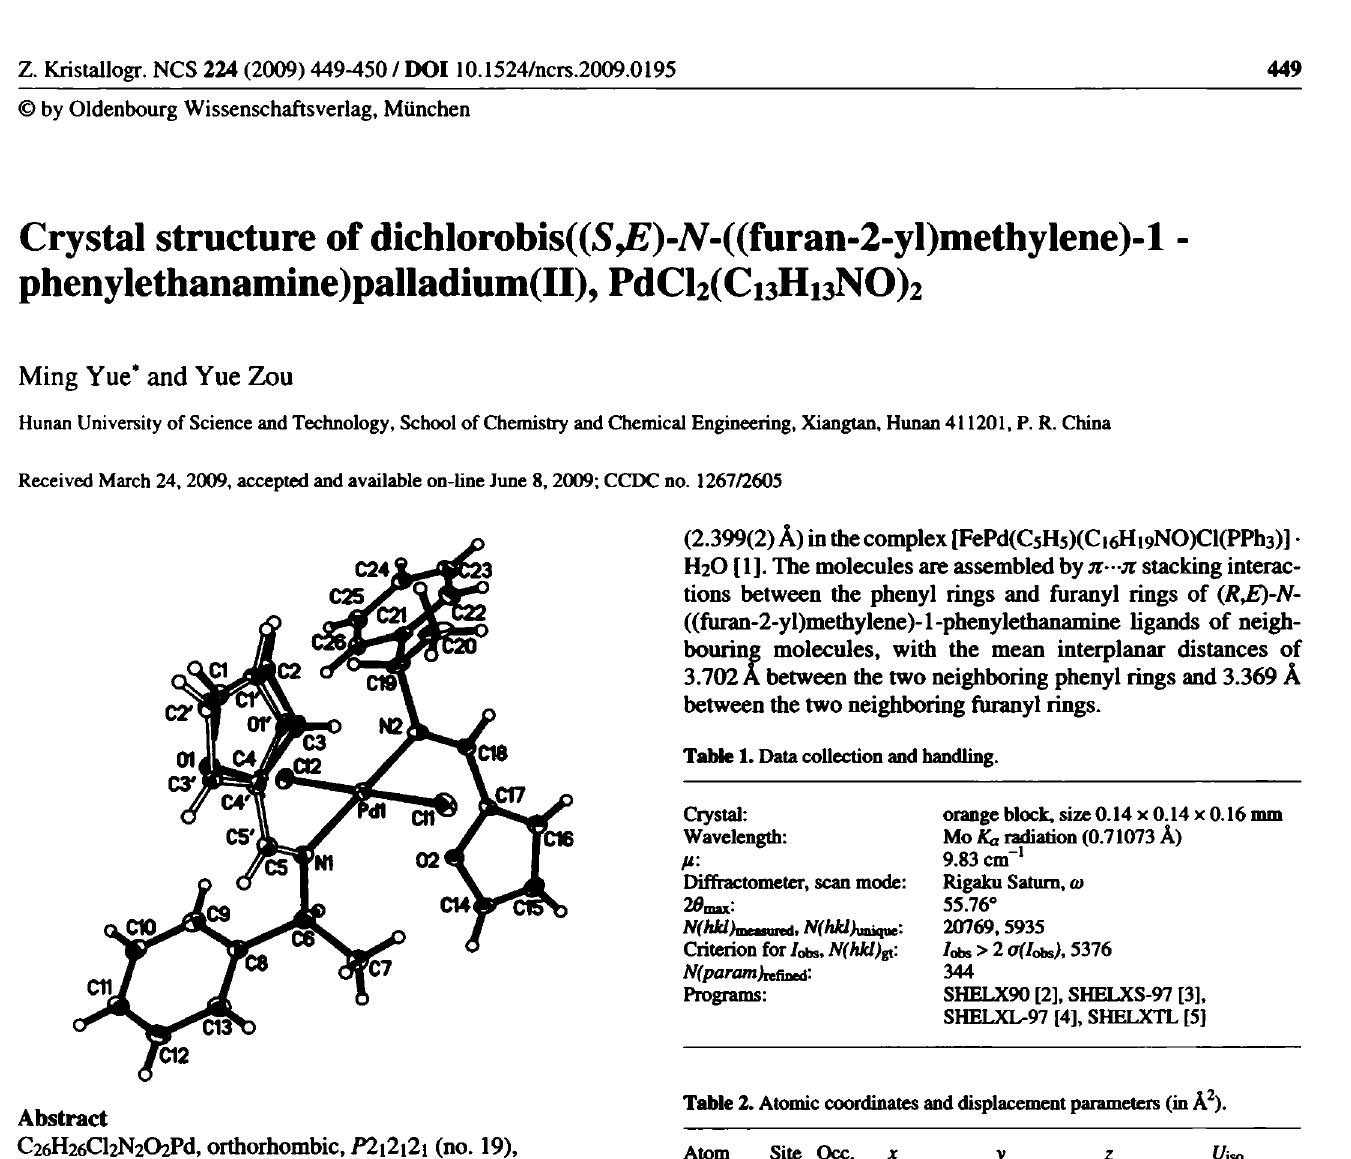
Table 2. Atomic coordinates and displacement parameters (in Â 2